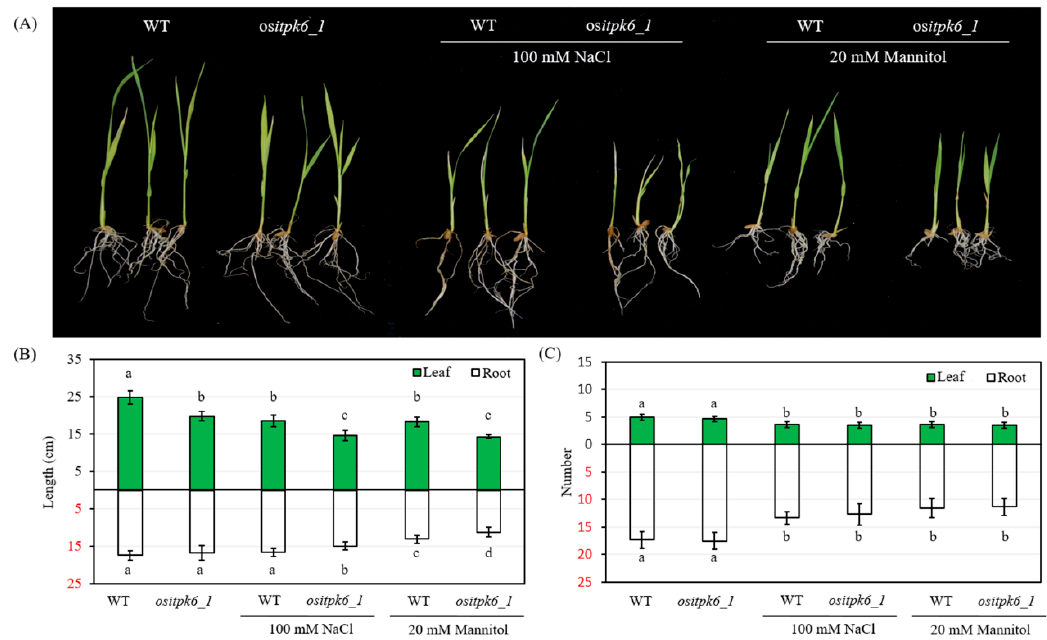
Figure 5. The phenotypes of the mutant OsITPK6_1 and wild type under salt stress (100 mM NaCl) and drought stress (20 mM mannitol). ( A ) The picture was taken on the 7th day after treatment. ( B , C ) Six replicates were performed for the OsITPK6 mutant line and the wild type. Error bars represent the standard error. The different letters show significant differences at a probability of p ˂ 0.05.